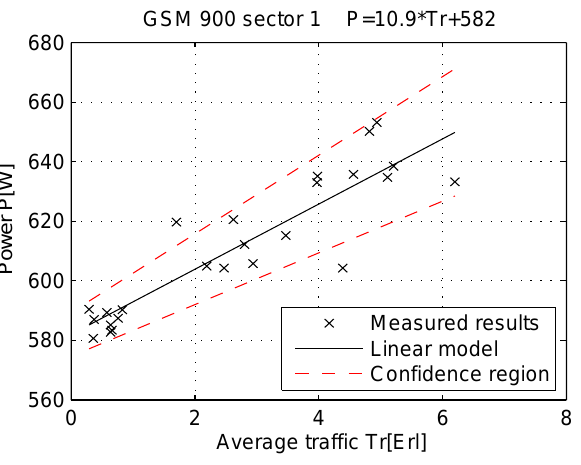
Figure 28. Power consumption model for GSM 900 sector 1 BS rack (Sunday 17/07).